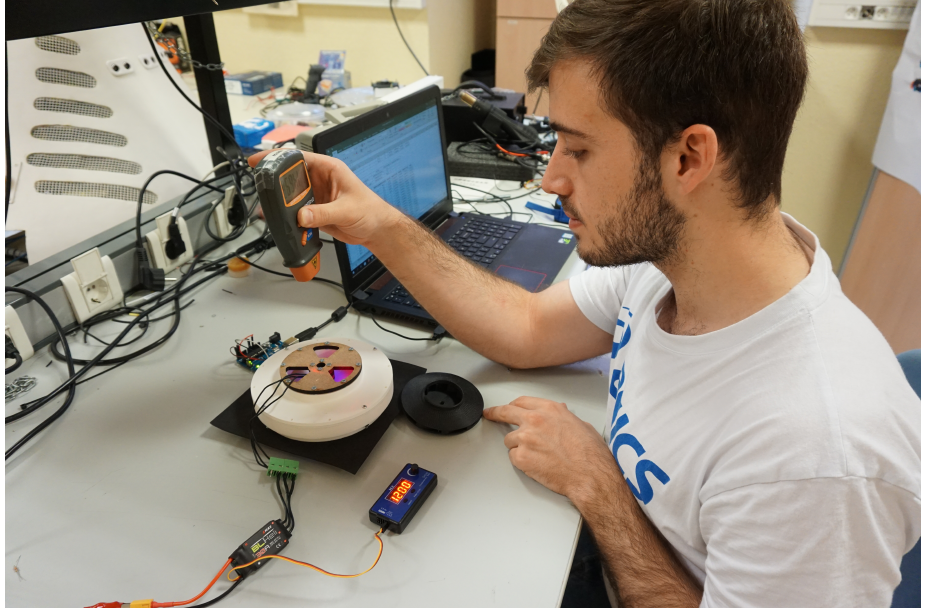
Figure 4. Test rig used to perform experimental